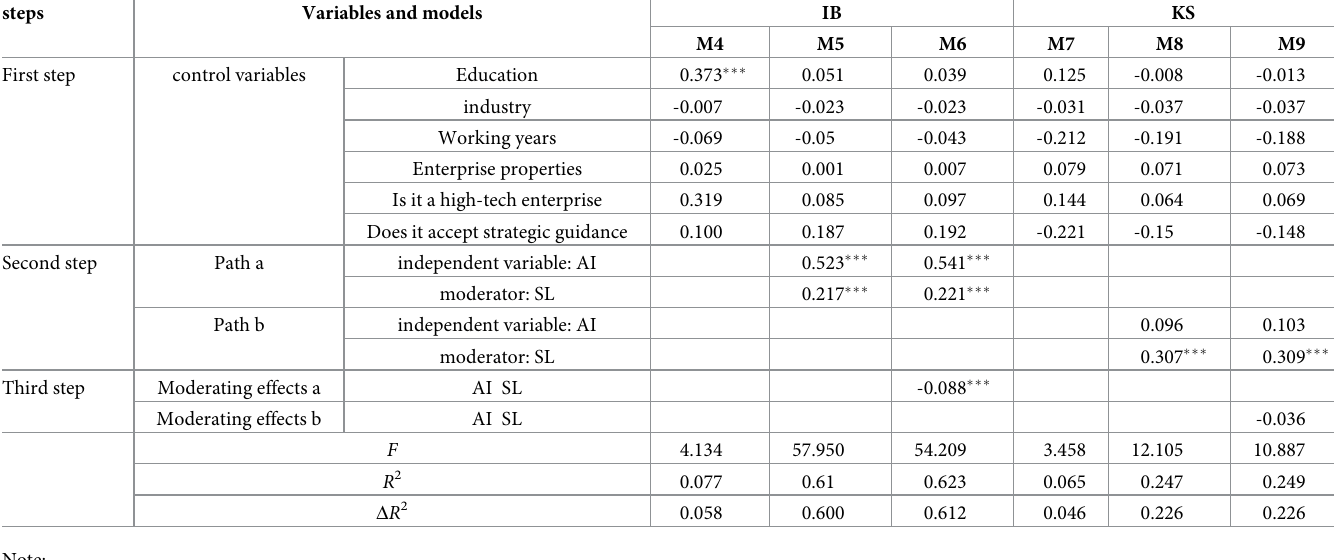
Table 8. Result of moderating